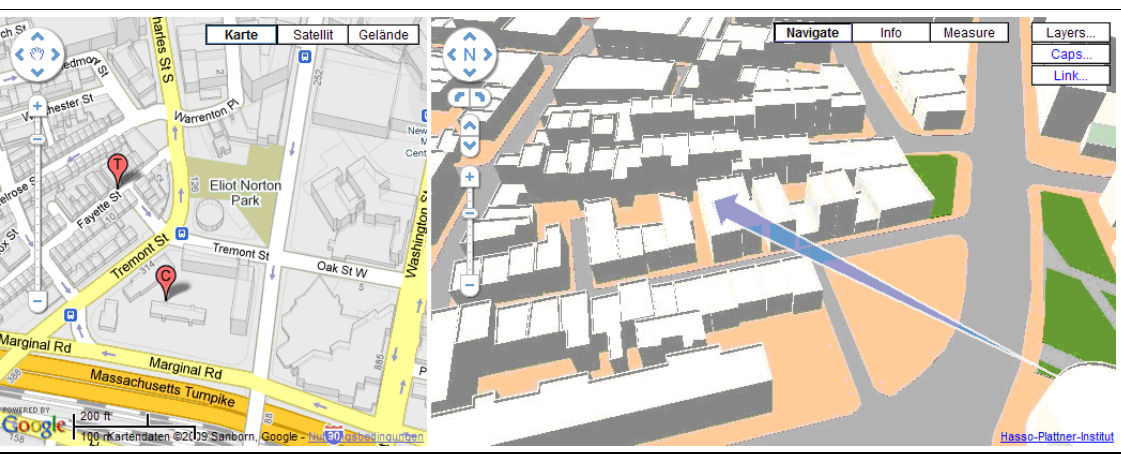
Figure 12. Screenshot of a viewer client of a 3DGeoVS based on SSI derived from the proposed SRA. The client demonstrates a mashup realizing CMV with a 2D map view ( left ) and a 3D perspective view ( right